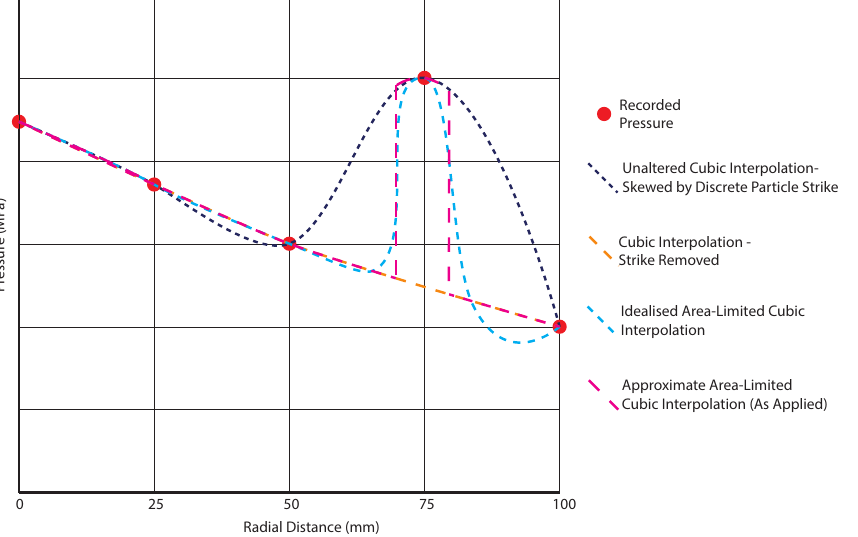
Figure 11. Diagram showing a simplified 1D approximation of the area-limiting process for a single cardinal direction with discrete particle strike at 75